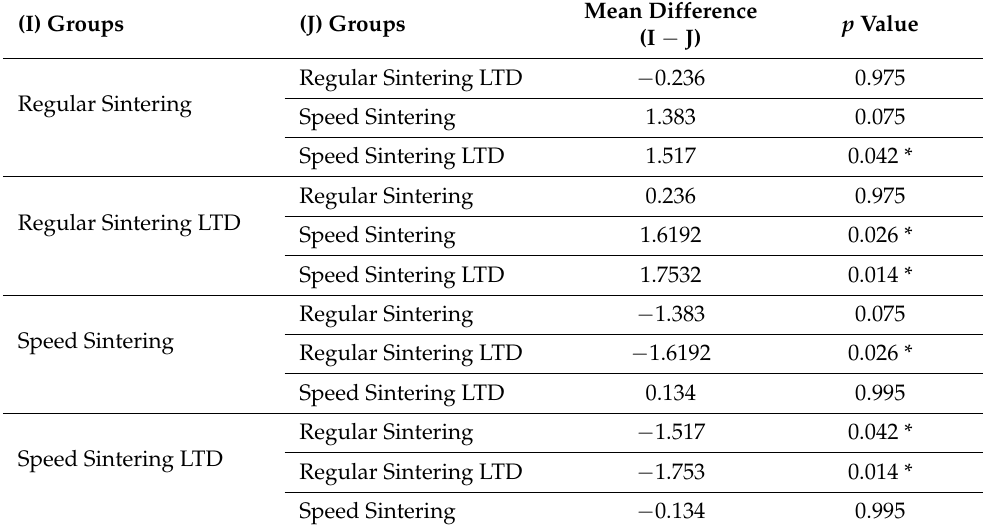
Table 2. Multiple comparisons of the grain size of the zirconia specimens among various groups. (I) Groups